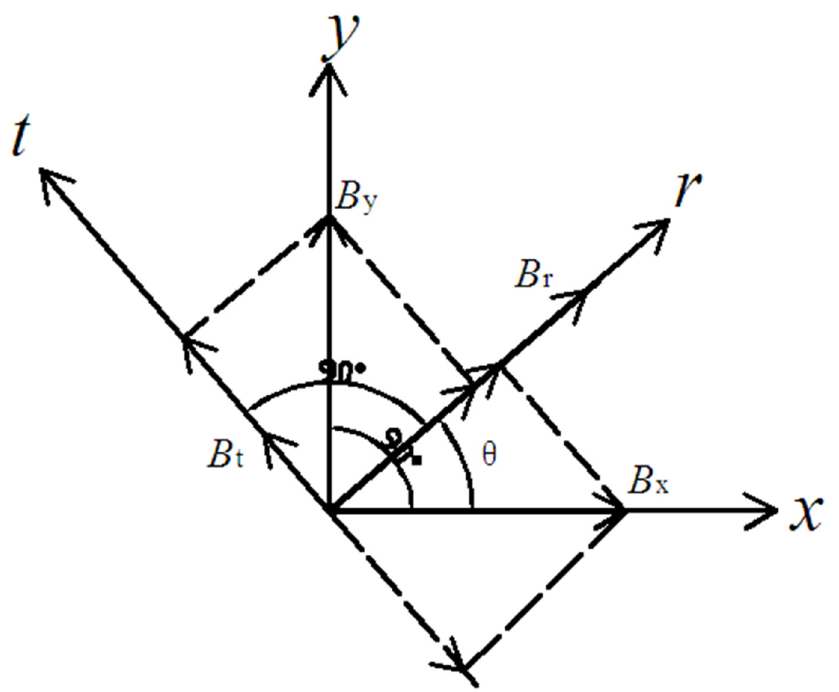
Figure 15. Calculation of normal and tangential flux density in the air